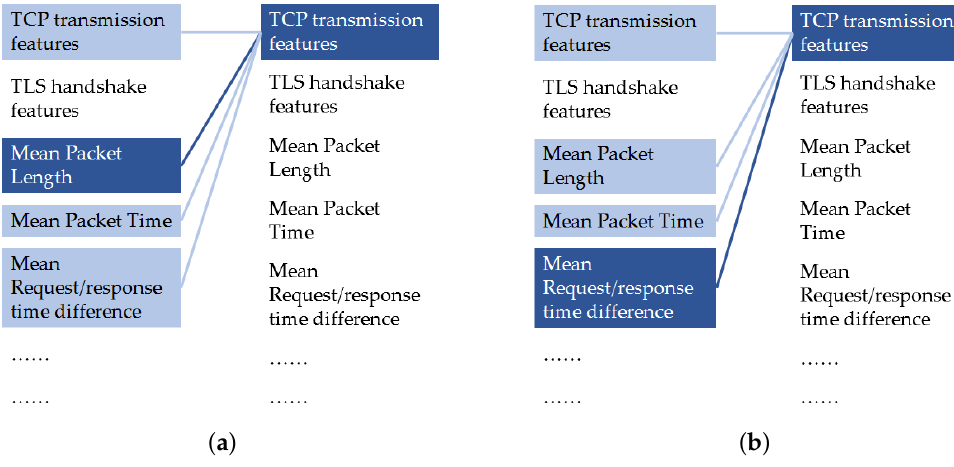
Figure 6. Interpretability of distribution of attention for features of traffic: ( a ) a distribution of attention; ( b ) another distribution of